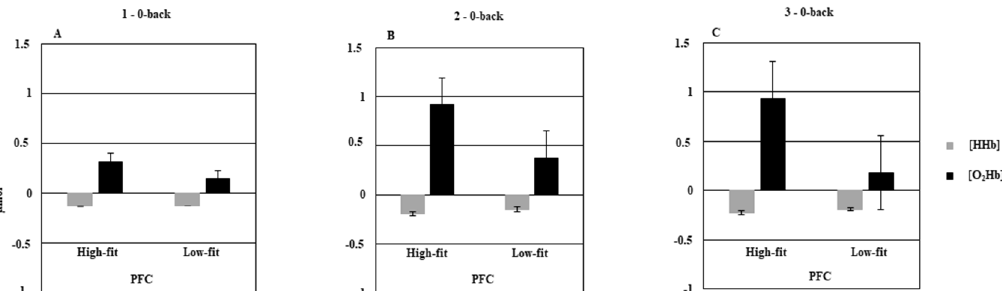
Figure 3. Hemodynamic concentration changes in prefrontal cortex (PFC) in low-fit and high-fit older adults as a function of cognitive load ( A = 1–0-back; B = 2–0-back; C = 3–0-back). Bars represent standard error.